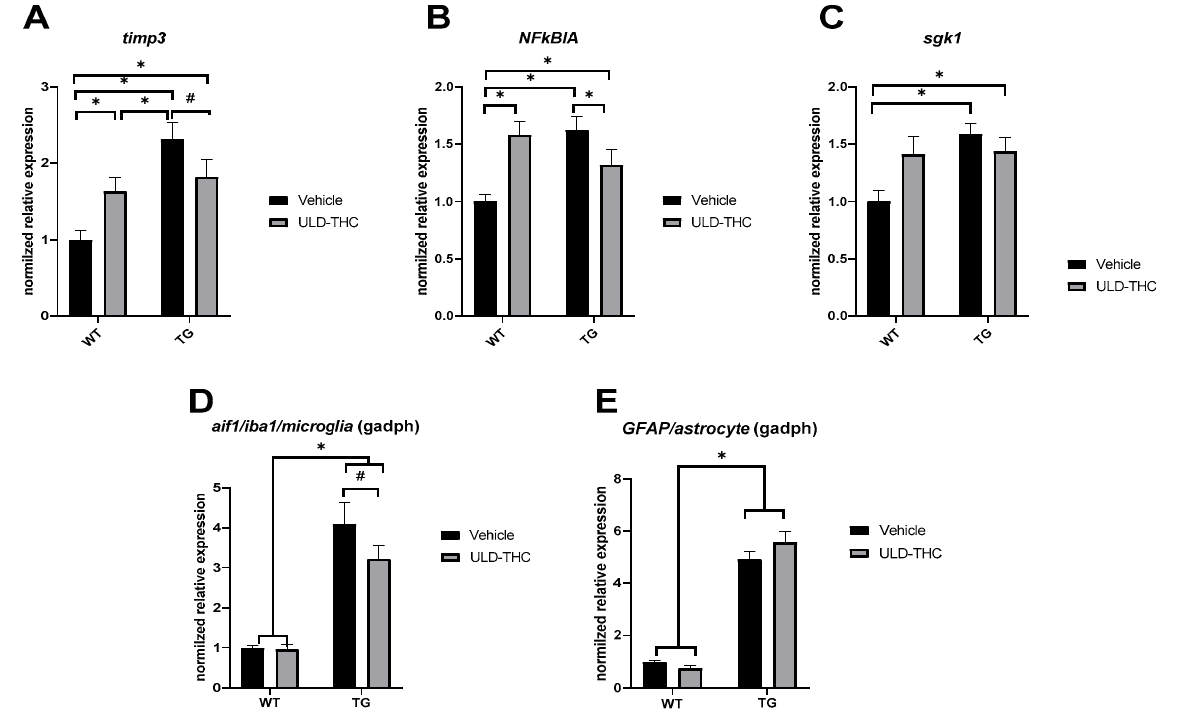
Figure 3. Inflammatory and glia markers of AD at six months. Relative expression in RT-PCR of Tissue Inhibitor of Metalloproteinase 3 ′ (TIMP-3) was elevated in non-treated AD mice compared to WT mice. Importantly, AD-treated mice had lower expression compared to non-treated mice ( A ). Relative expression of the Nfkbia gene was elevated in non-treated AD mice compared to WT mice. Importantly, AD-treated mice had lower expression compared to non-treated mice ( B ). Relative expression of Glucocorticoid activated kinase (Sgk) was higher in non-treated AD mice and in AD- treated mice compared to WT mice ( C ). The relative expression of both aif1 gene ( D ), related to microglia and GFAP gene ( E ); related astrocytes were upregulated in non-treated AD mice compared to WT mice. Notably, in the aif1 gene, AD-treated mice showed a trend toward less gliosis compared to non-treated mice. n = 7–10. * indicates p > 0.05, # indicates p = 0.06, Mean ± SEM.